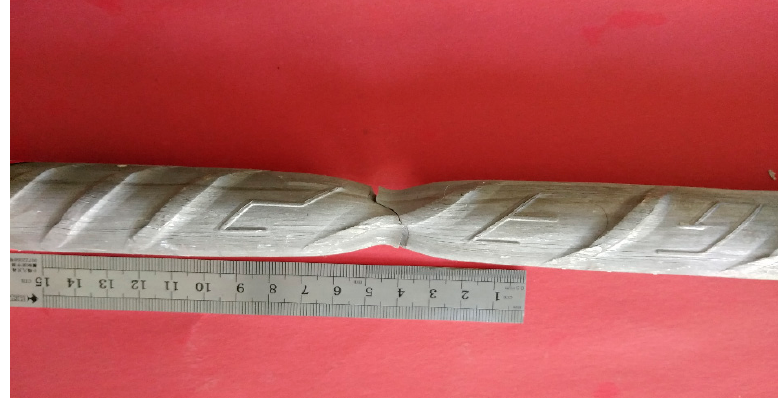
Figure 1. Fracture location of duplex stainless steel bars.